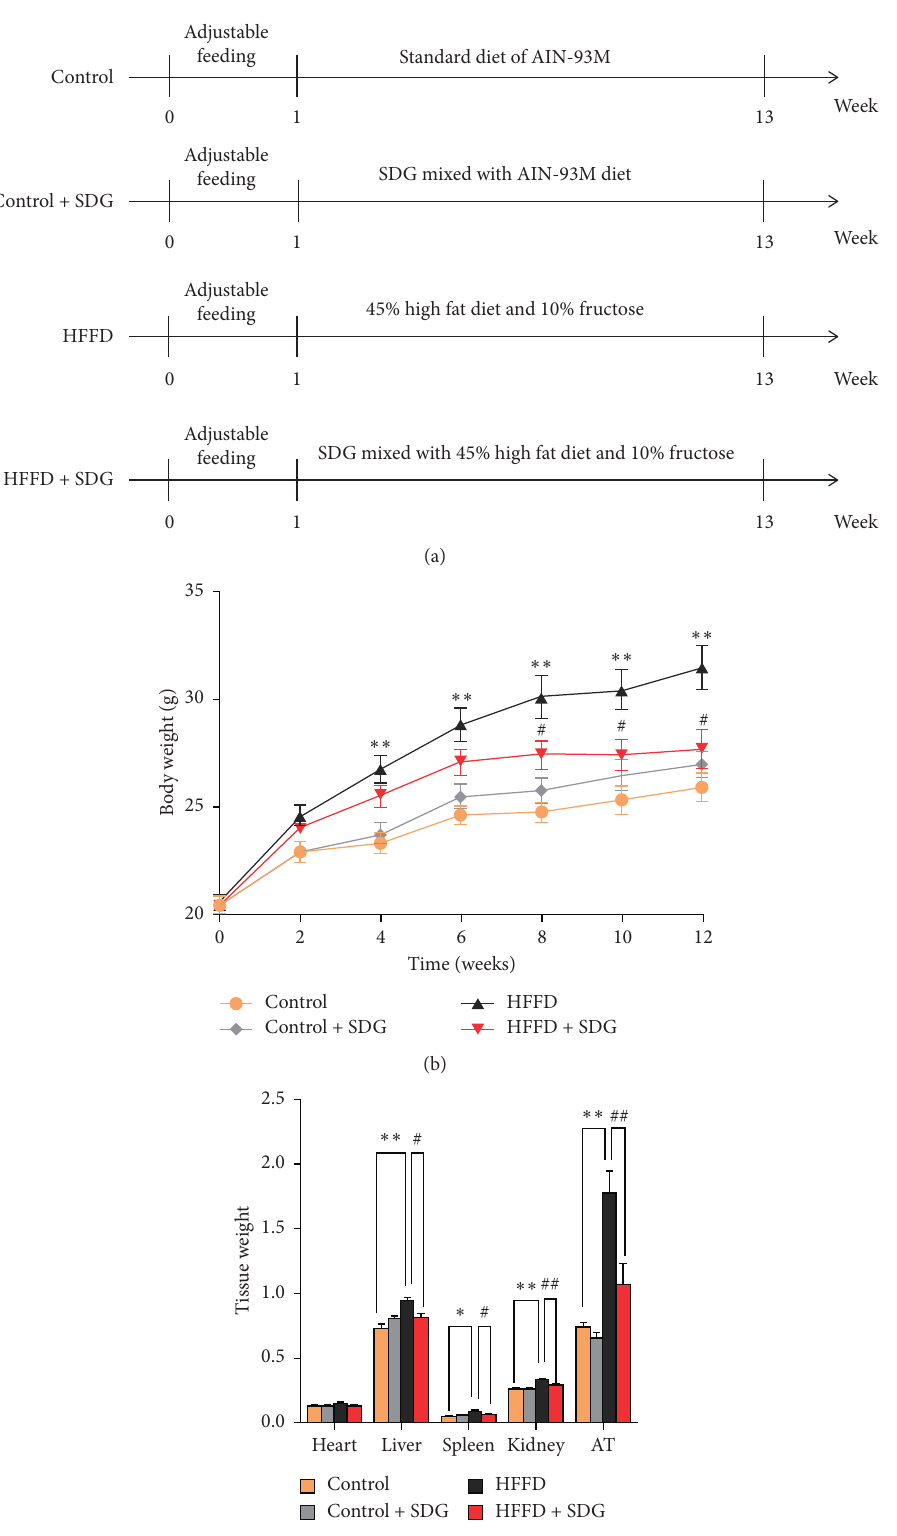
Figure 2: SDG inhibits weight gain in HFFD-fed mice. (a) Test design and groups; (b) trends in body weight during feeding and (c) tissue weight to body weight ratio (heart, liver, spleen, kidney, adipose tissue (AT)). Data are represented as mean ± SEM, n � 10 biologically independent animals. ∗ p < 0 . 05, ∗∗ p < 0 . 01 versus the control group; # p < 0 . 05, ## p < 0 . 01 versus the HFFD